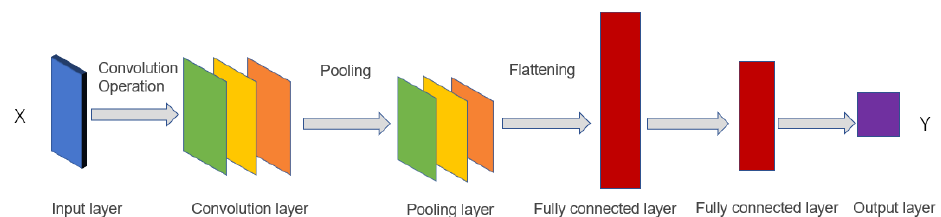
Figure 1. Traditional convolutional neural network.